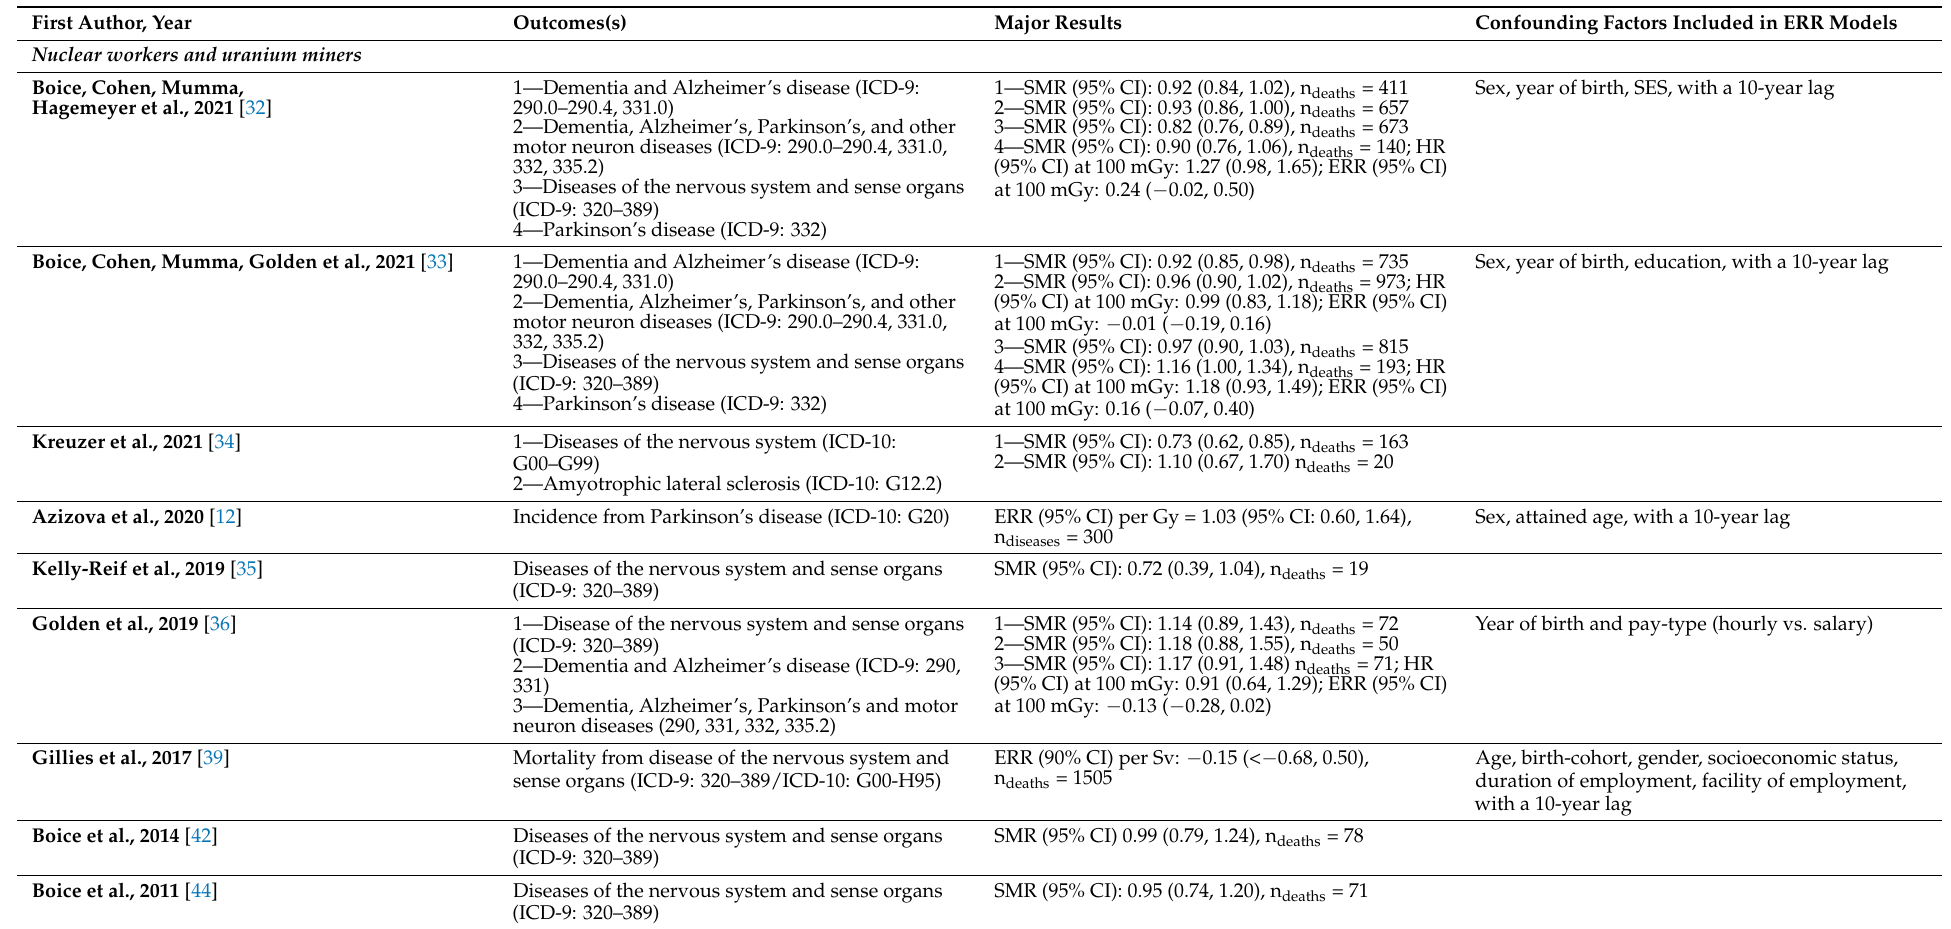
Table 2. Key findings of the included studies on diseases of the nervous